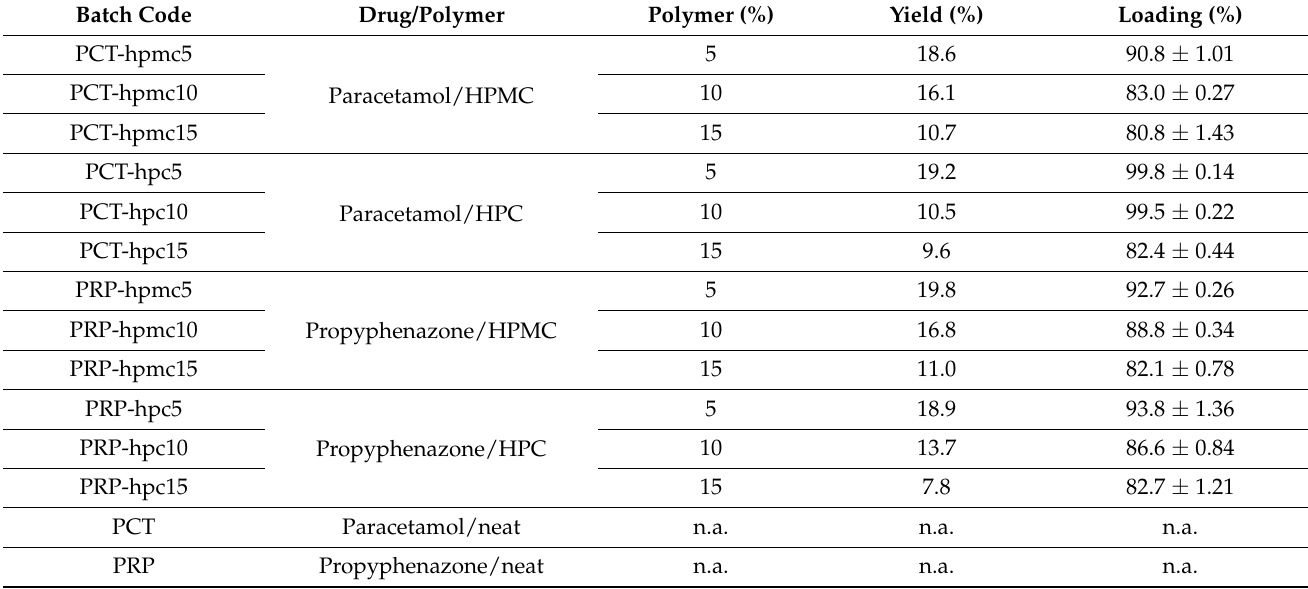
Table 1. Factorial experimental design (DoE is described by the first twelve rows after column titles), batch codes, composition, co-spray drying yield and loading (mean ± SD). Batch